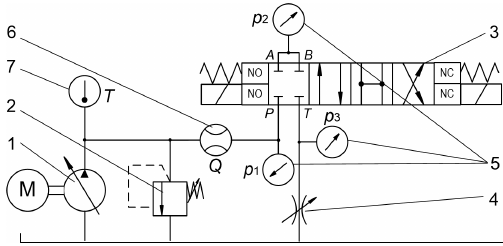
Figure 16. Test bench scheme: 1—pump, 2—relief valve, 3—tested 4/4 UREZ 6 valve, 4—throttle valve, 5—pressure transducers, 6—flow meter, 7—temperature gauge.